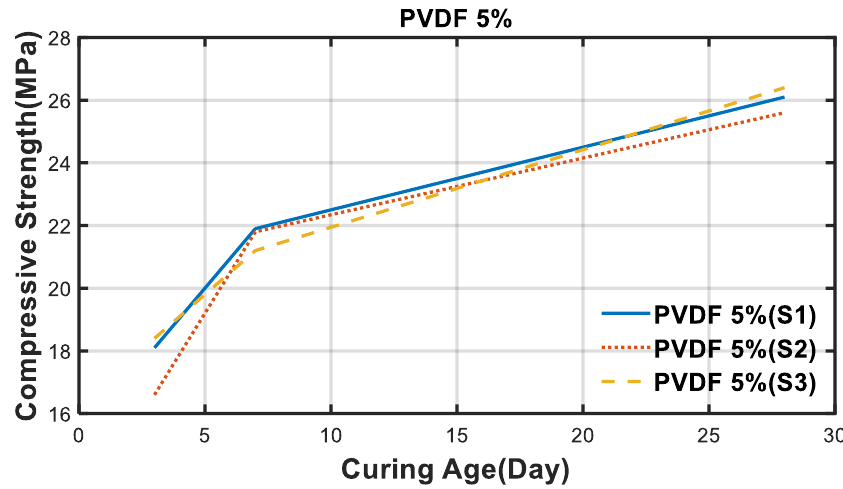
Figure 11. Graph of strength measurement results between PVDF (5%) specimens.